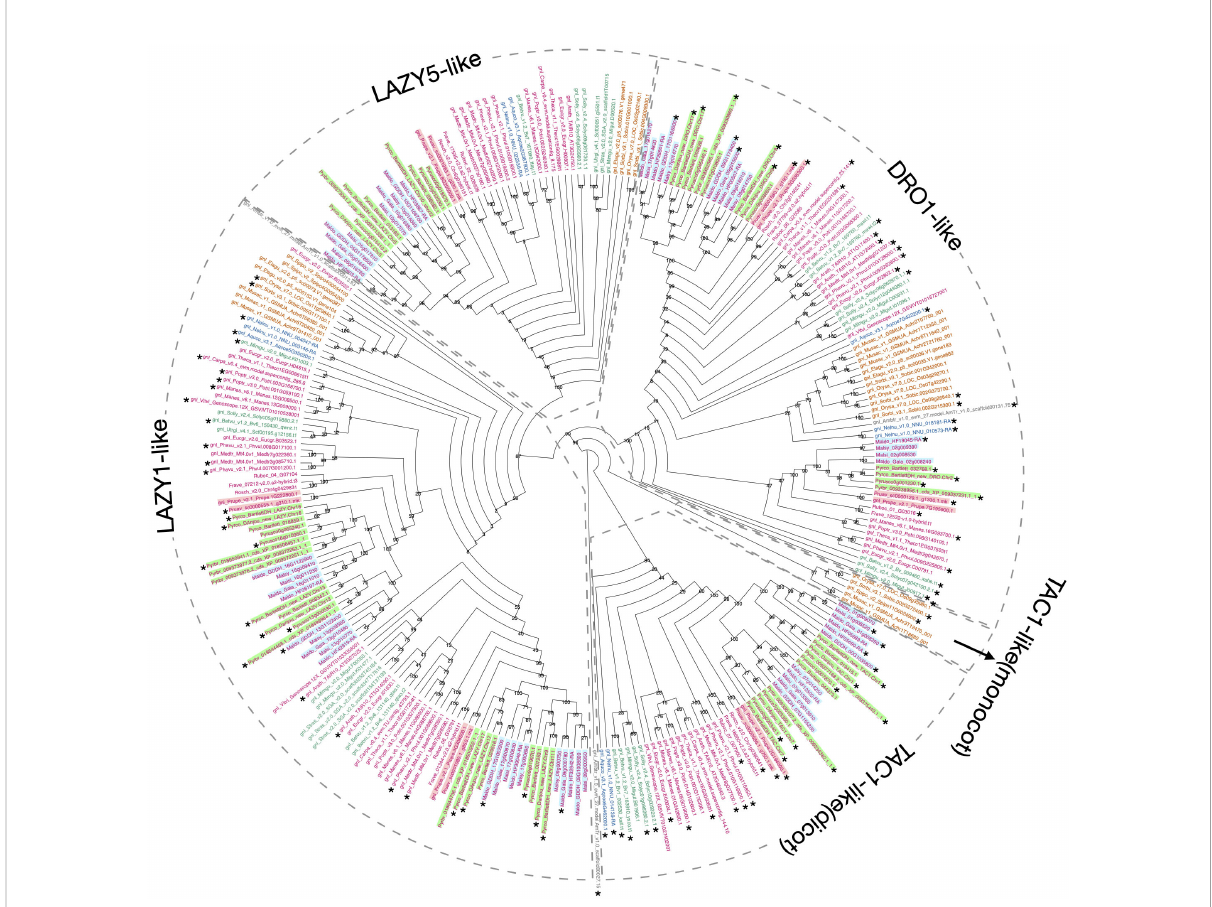
FIGURE 5 Phylogeny comparison of IGT genes. Cladogram of the IGT gene family (including LAZY1-like, LAZY5-like, TAC1-like, and DRO-like, separated by gray dotted boxes). The TAC1-like group was further divided into two monophyletic groups, with one containing only monocot genes and the other containing dicot genes. Genes are colored and highlighted as shown in Supplementary Figure 3. 1000 bootstrap replicates were conducted to estimate reliability and the numbers on the node indicate bootstrap support. Gene models with the expected domain structure and intron-exon structure were marked with